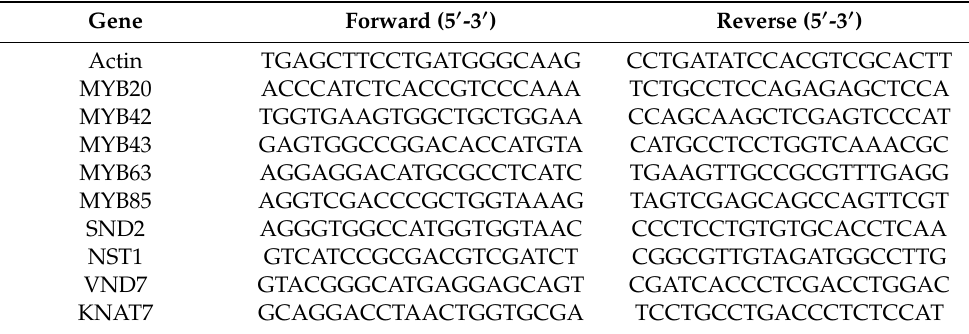
Table 1. Primers used for reverse transcription quantitative PCR. Gene